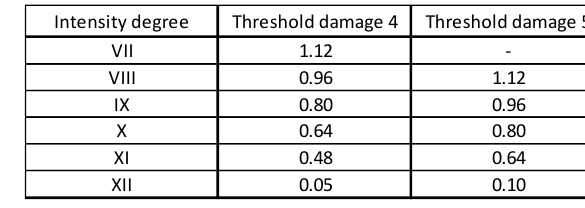
Table 6. Threshold indices by degree of intensity and level of